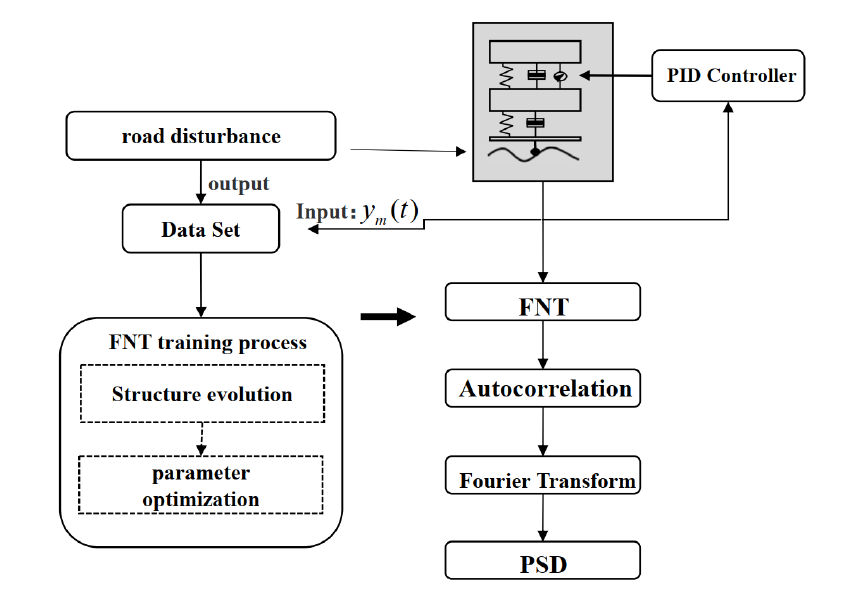
Figure 3. Framework diagram of the FNT-based road spectral density fitting